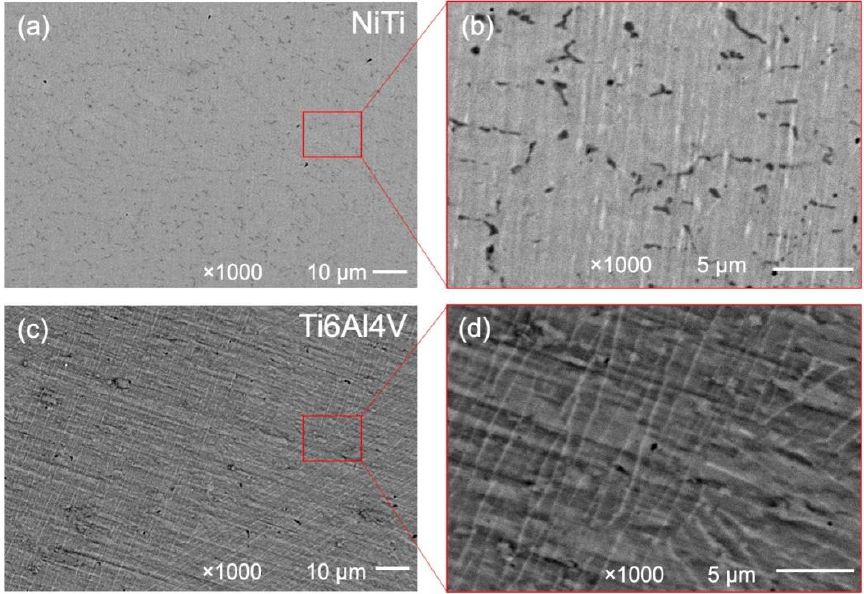
Figure 2. Microstructure of LB-DED NiTi ( a , b ) and Ti-6Al-4V ( c , d ) alloys with two different magnifications (1000× and 5000×).